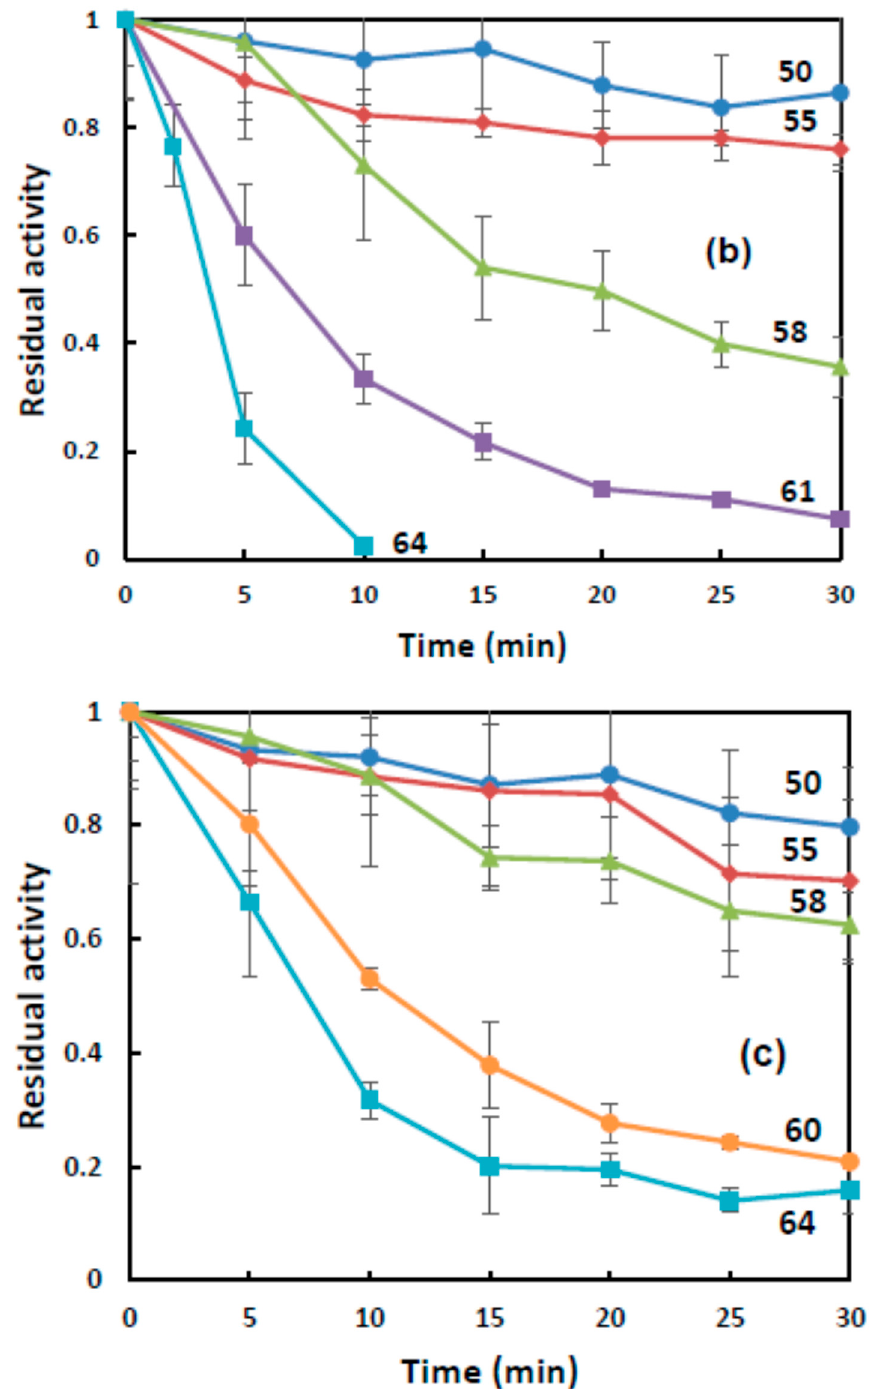
Figure 2. Time course of thermal inactivation of butyrylcholinesterase (BChE) at various temperatures ranging from 50 to 64 °C in buffer ( a ), 1.4% gelatin gel ( b ), and 3% starch gel ( c ). Numbers on curves correspond to temperature values (°C).